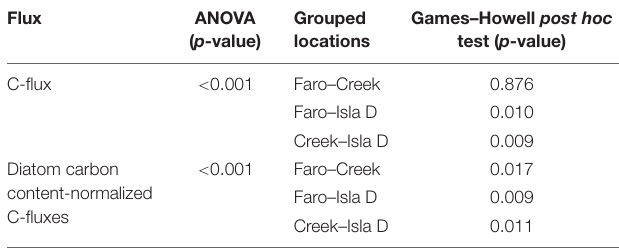
TABLE 2 | p -values of ANOVAs and Games–Howell post hoc tests regarding sediment core specific slopes of C-fluxes ( Figure 3 ) and diatom carbon content-normalized C-fluxes ( Figure 4 ), both plotted against